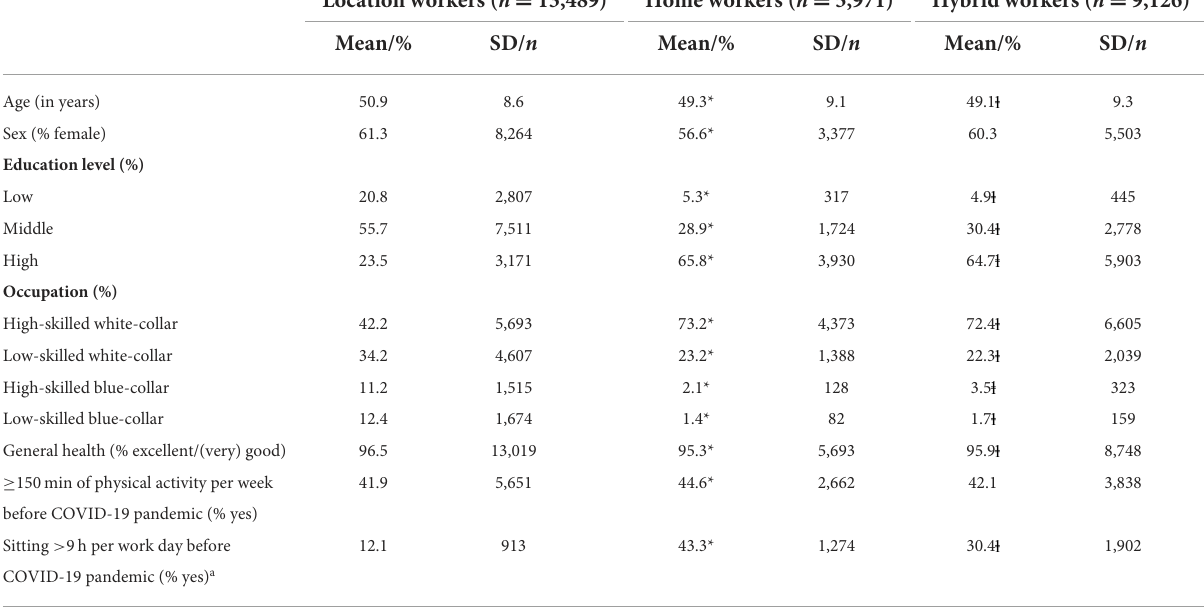
TABLE 1 Characteristics of the study population stratified for location workers, home workers, and hybrid workers (who worked both on location and from home) during the COVID-19 pandemic from March 2020 to January 2022 ( n = 28,586). Location workers ( n =